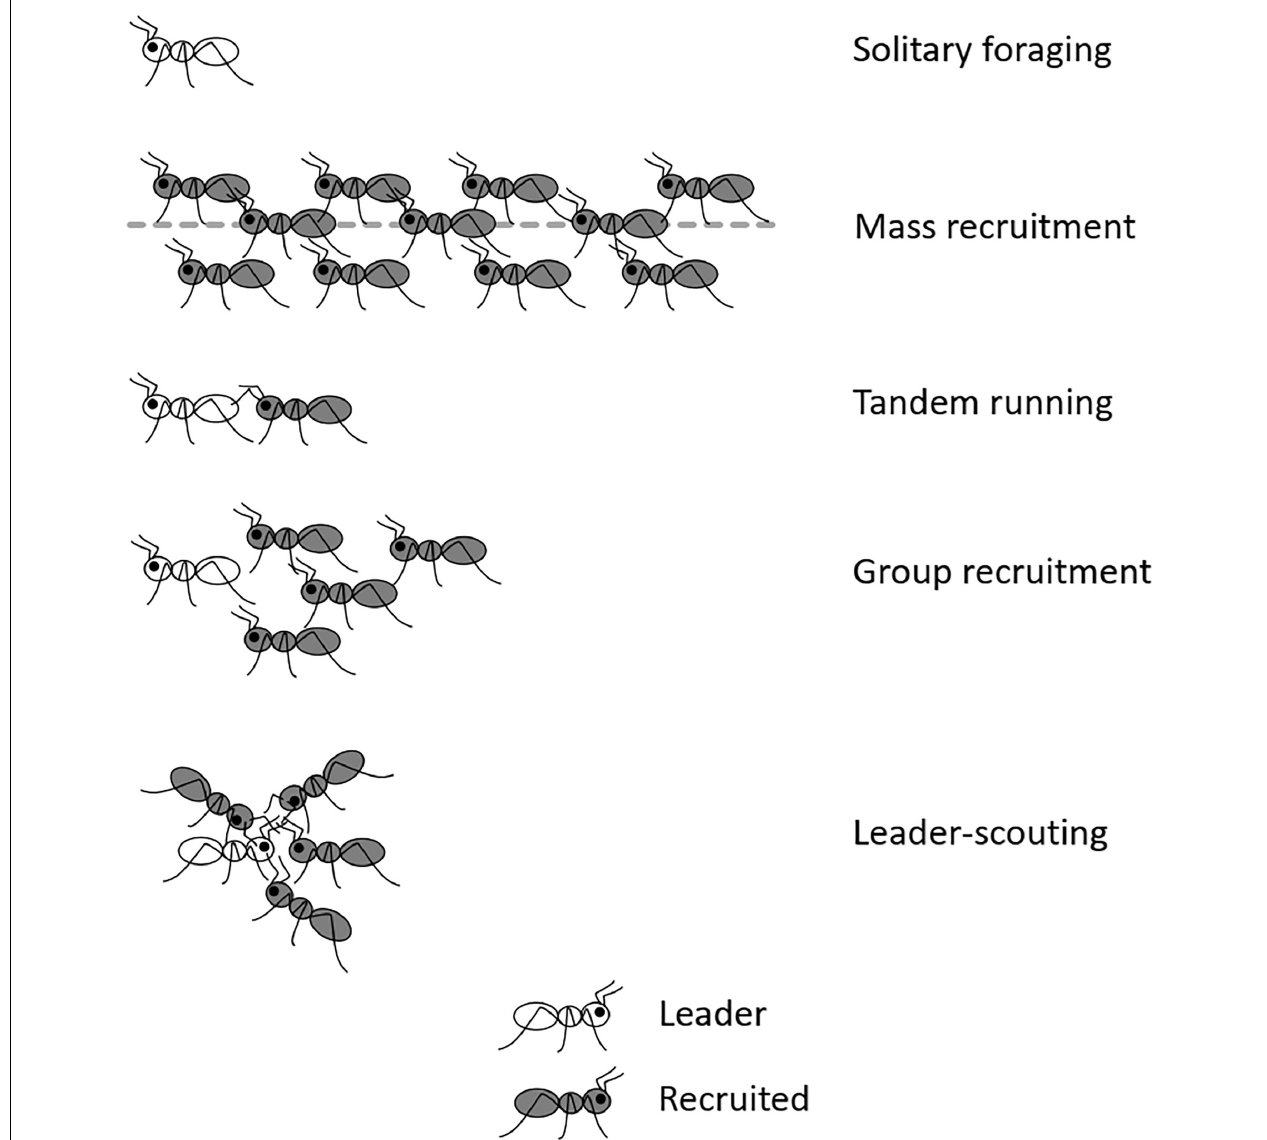
FIGURE 1 | Four main categories of recruitment strategy in ants: mass recruitment, tandem running, group-recruitment, and